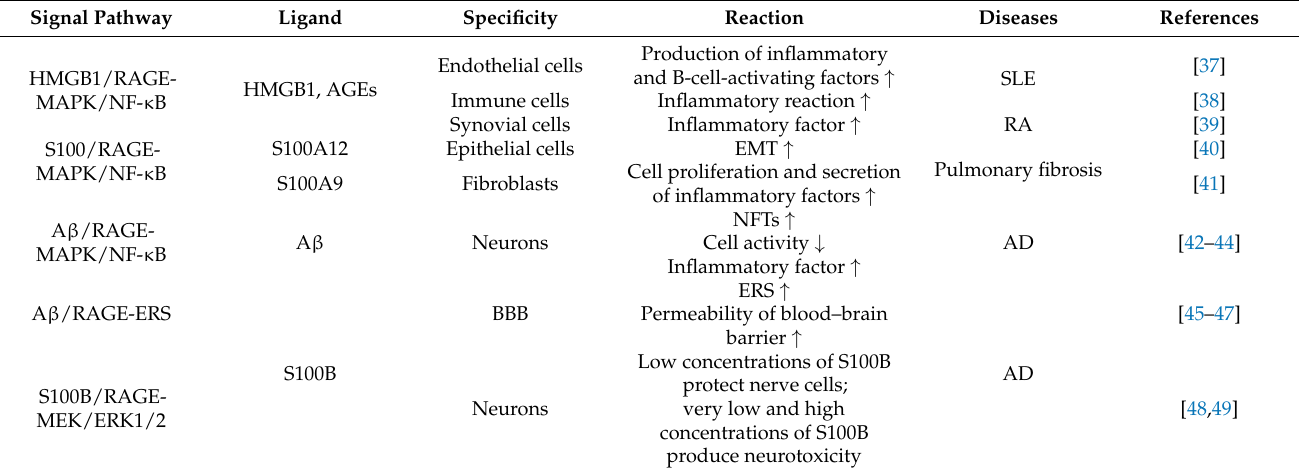
Table 1 summarizes the related ligands and mechanisms of the RAGE-MAPK/NF- κ B pathway in SLE, RA, pulmonary fibrosis, and AD. Table 1. The role of RAGE-related signaling pathways in immune-associated